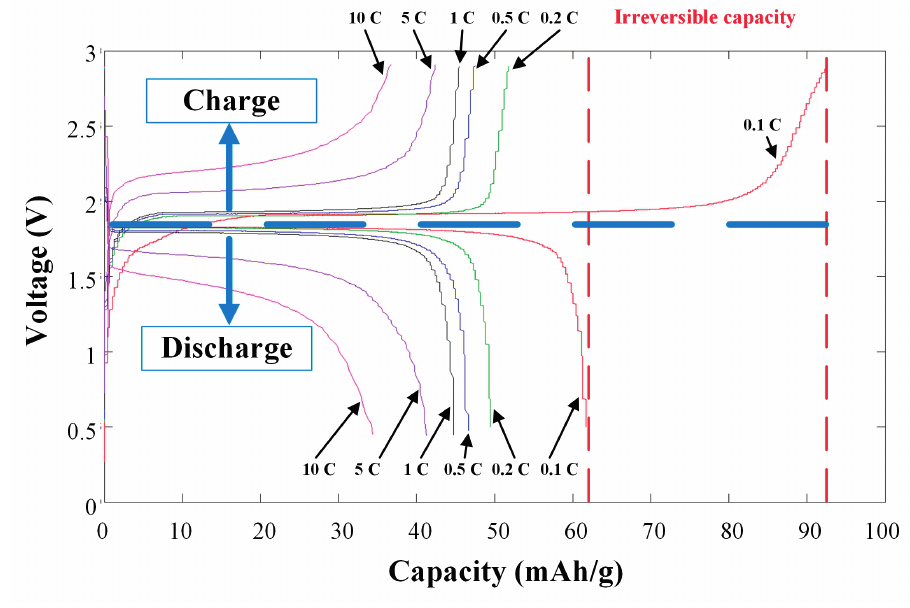
Figure 8. Charge-discharge test curve diagram of the coin cell embedded with flexible three-in-one microsensors.